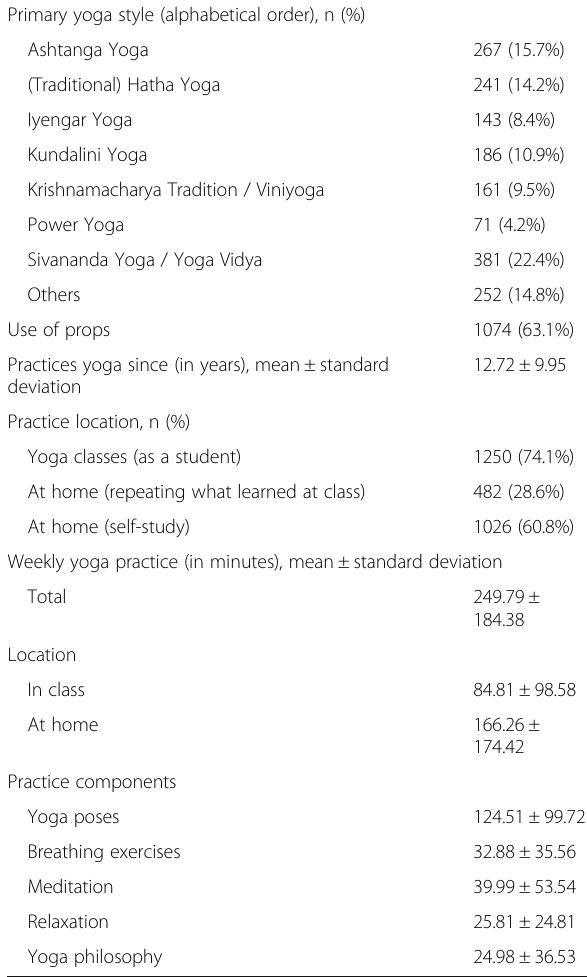
Table 2 Yoga practice characteristics Primary yoga style (alphabetical order), n